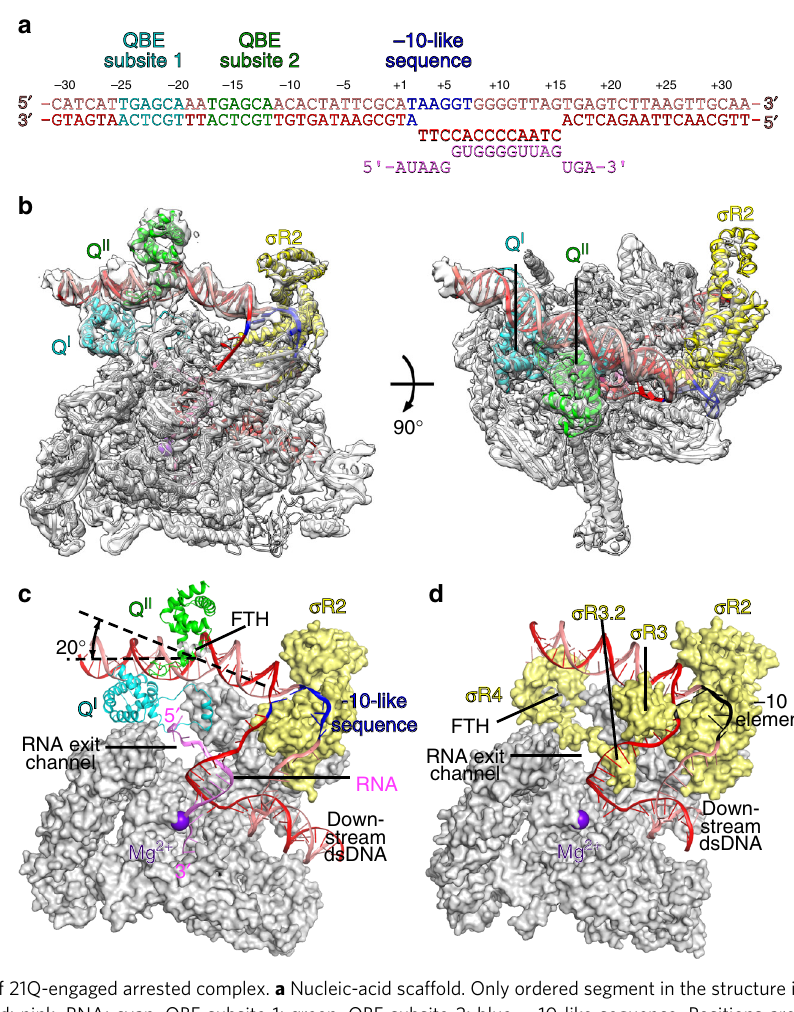
Fig. 2 Cryo-EM structure of 21Q-engaged arrested complex. a Nucleic-acid scaffold. Only ordered segment in the structure is shown. Salmon, nontemplate strand; red, template strand; pink, RNA; cyan, QBE subsite 1; green, QBE subsite 2; blue, − 10-like sequence. Positions are numbered relative to the transcription start site. b The cryo-EM density map without B-factor sharpening and the superimposed model of 21Q-engaged arrested complex. Gray, RNAP; cyan, Q I ; green, Q II ; yellow, σ 70 ; violet, active center Mg 2 + ; salmon, nontemplate strand; red, template strand; pink, RNA; blue, − 10-like sequence. c The model of 21Q-engaged arrested complex. RNAP and σ 70 are shown as surfaces. View orientation and colors as in the left subpanel of b . β , except the FTH, is omitted for clarity. d The model of RPo (PDB 4YLN [10.2210/pdb4YLN/pdb]). View orientation and colors as in c , except that the promoter -10 element is colored